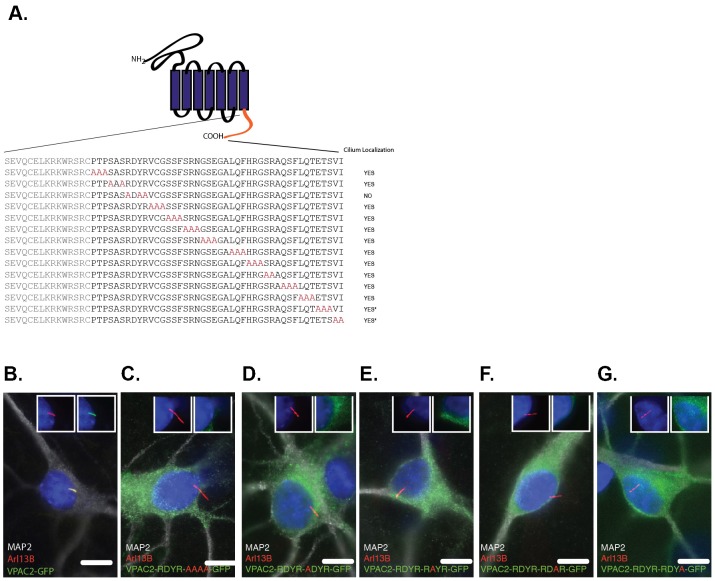
The RDYR motif is necessary for VPAC2 ciliary targeting.(A) Summary of the alanine-scanning mutagenesis performed for the last 44 amino acids of the VPAC2 C-terminus. IMCD3 cells expressing GFP tagged VPAC2 harboring indicated alanine mutations (*GFP tag is in the N-terminus) were serum starved (supplementary material Fig. S2). The RDYR→ADAA mutation but not others abolished ciliary localization of GFP tagged VPAC2. (B) VPAC2-GFP localizes to primary cilia in SCN cells. SCN cells expressing VPAC2-GFP were immunostained for MAP2 (white) and Arl13B (red). (C–G) RDYR motif is required for VPAC2 ciliary targeting. SCN cells expressing VPAC2 harboring the RDYR→ADAA mutation or single mutations in the RDYR motif were immunostained for MAP2 (white) and Arl13B (red). DNA was labeled with DAPI (B–G). Insets show an unmerged image of the region around the cilium. Scale bars: 5 µm.